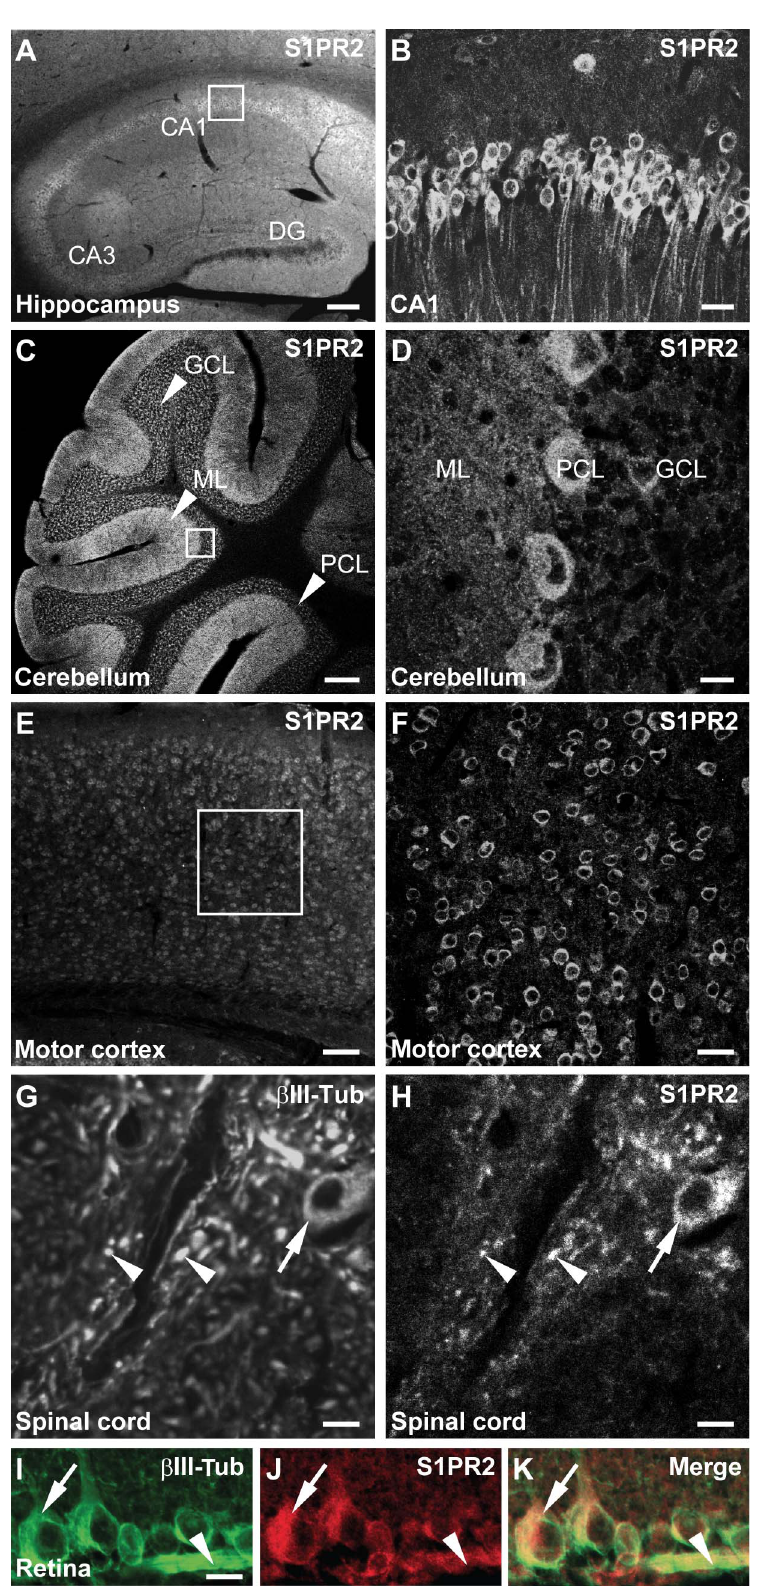
Figure 1. Localization of S1PR2 by immunohistochemistry in the adult mouse CNS. (A) S1PR2 expression in the hippocampus. CA, cornu ammonis ; DG, dentate gyrus. (B) Magnification of the boxed region of CA1 depicted in (A). (C) S1PR2 expression in the cerebellum. GCL, granule cell layer; ML, molecular layer; PCL, Purkinje cell layer. (D) Magnification of the boxed region depicted in (C). (E) S1PR2 expression in the motor cortex. (F)